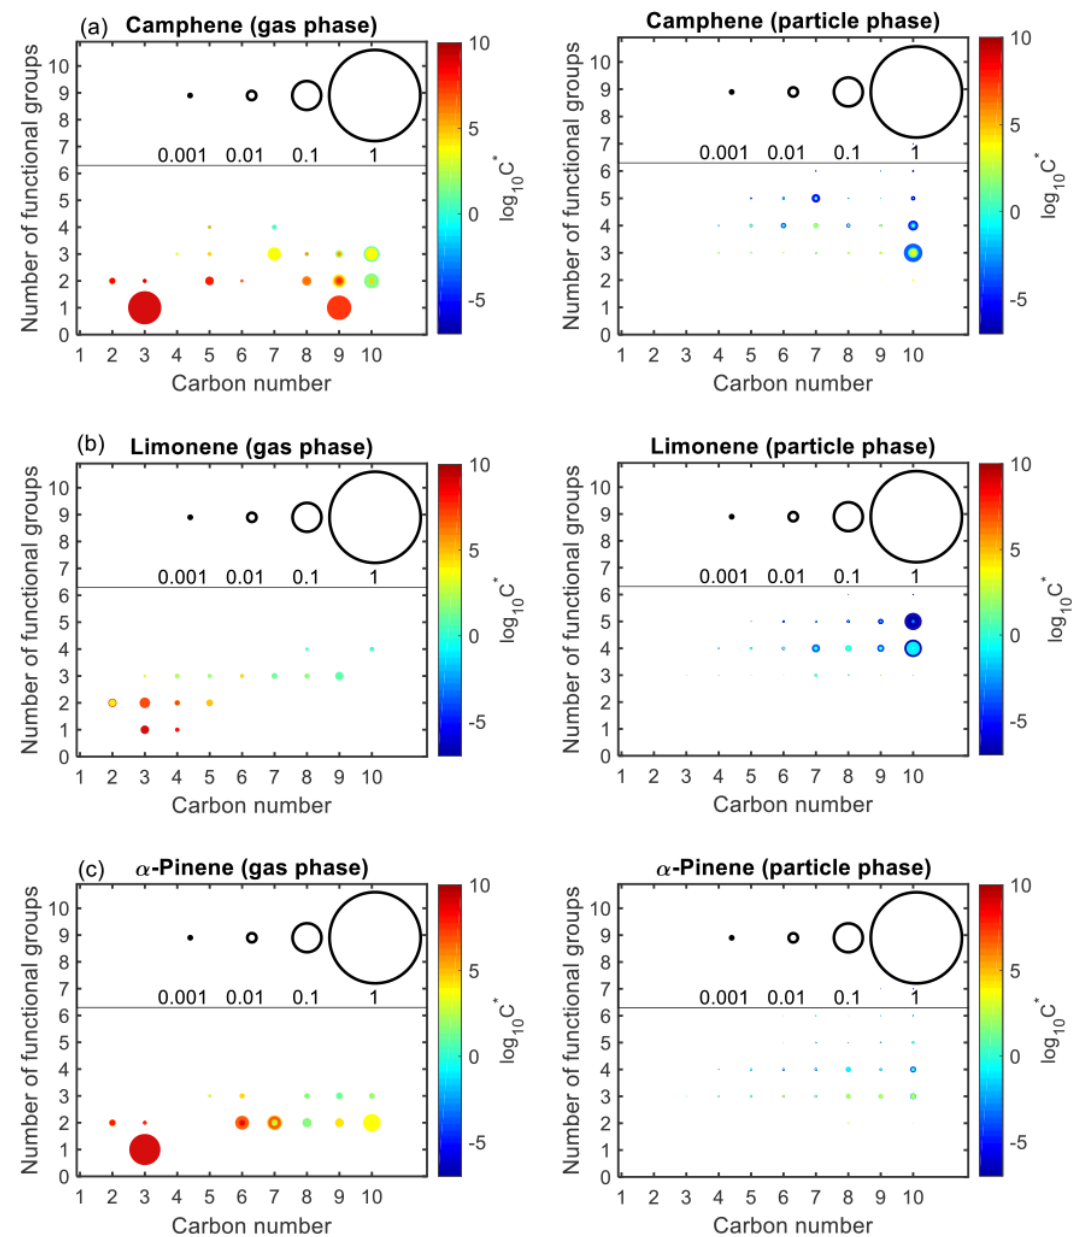
Figure 10. Number of functional groups associated with gas- and particle-phase species as a function of carbon number. Results are shown for camphene, α -pinene, and limonene after 72h of oxidation under controlled reactivity conditions. The markers are sized by the ratio of their mixing ratio (in ppbC) to the initial mixing ratio of the precursor (in ppbC). The colors of the markers are scaled by volatility (represented by saturation concentration, C ∗